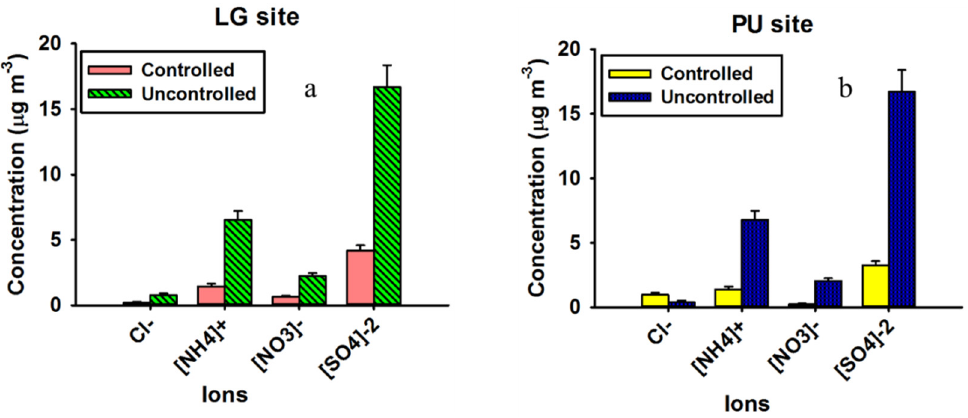
Figure 3. Average (µg·m − 3 ) water-soluble ions observed in PM 2.5 at the LG site ( a ) and PU site ( b ) during controlled and uncontrolled periods.